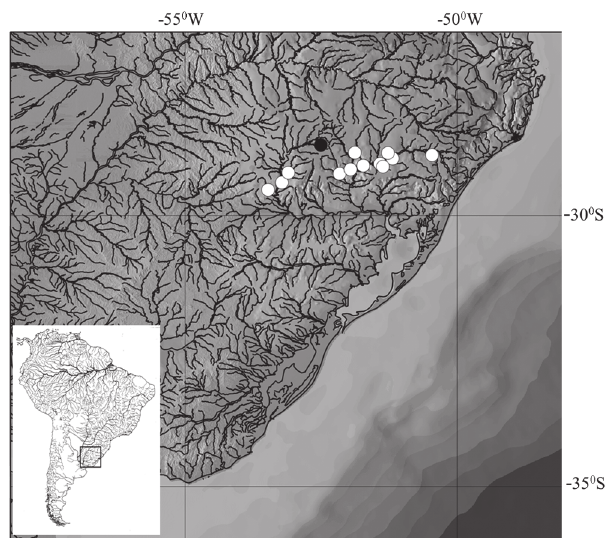
Fig. 6. Map of southern Brazil and Uruguay, showing the distribution of the material examined of Astyanax procerus . Some symbols represent more than on lot or locality. Black circle = type